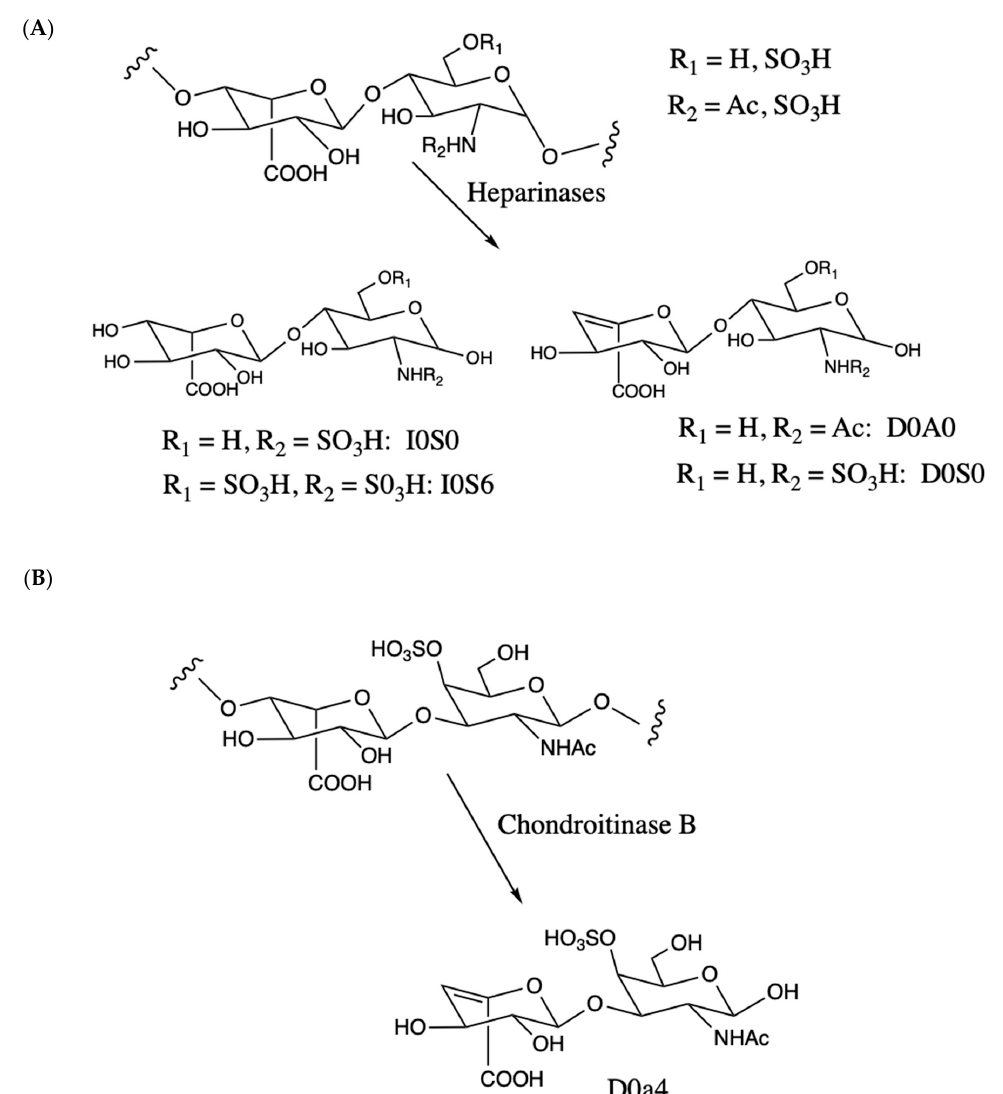
Figure 1. ( A ). Heparan sulfatide disaccharide repeat unit showing sulfation or acetylation on the amino group or sulfation on the 6-position of glucosamine. The 2-position of the iduronic acid residue can also be sulfated (not shown). Degradation with bacterial heparinase lyases yield internal disccharides containing an unsaturated uronic acid (D0A0, D0S0, right) plus the non-reducing end disaccharides that lacks unsaturation (I0S0, I0S6, left). ( B ). Dermatan sulfate (chondroitin sulfate B) disaccharide repeat unit showing sulfation at the 4-position of GalNAc (major disaccharide in dermatan sulfate). Digestion with chondroitinase B lyase generates unsaturated internal disccharides (D0a4) and the non-reducing end lacking unsaturation (not shown). In the internal disaccharide method, the disaccharides are analyzed without derivatization. With Sensi-Pro and Sensi-Pro Lite, the disaccharides are derived at carbon-1 of the amino-sugar with aniline/NaCNBH 3 (not shown). Endogenous enzymes present in human tissues can also cleave GAG chains, and an endogenous disaccharide biomarker was reported to be elevated in urine from MPS-I patients [10]. This biomarker contains a uronic acid (iduronic acid or glucuronic acid) linked to N-acetyl-hexosamine (GlcNAc or GalNAc) and contains a single sulfate [11]. Its exact structure is unknown, and we refer to it as UA- HNAc(1S) (presumably UA is iduronic acid rather than glucuronic acid, but this was not proven).